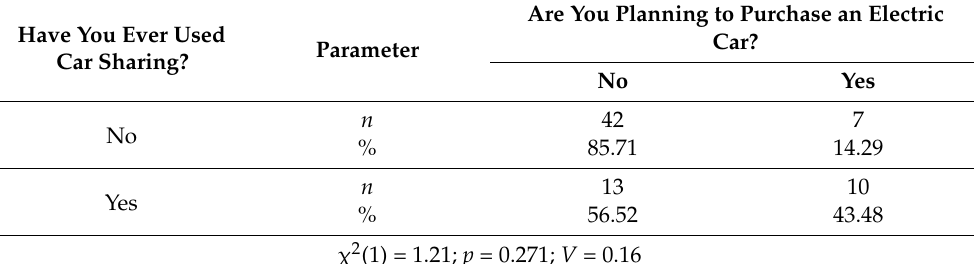
Table 11. Car-sharing use according to willingness to purchase an electric car. Have You Ever